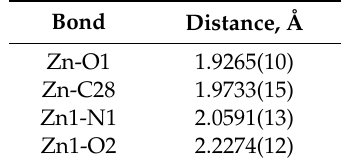
Figure 2. Molecular structure of the complex 4 . The probability for thermal ellipsoids is set to the 50% level. Table 4. The Zn-L bond distances.